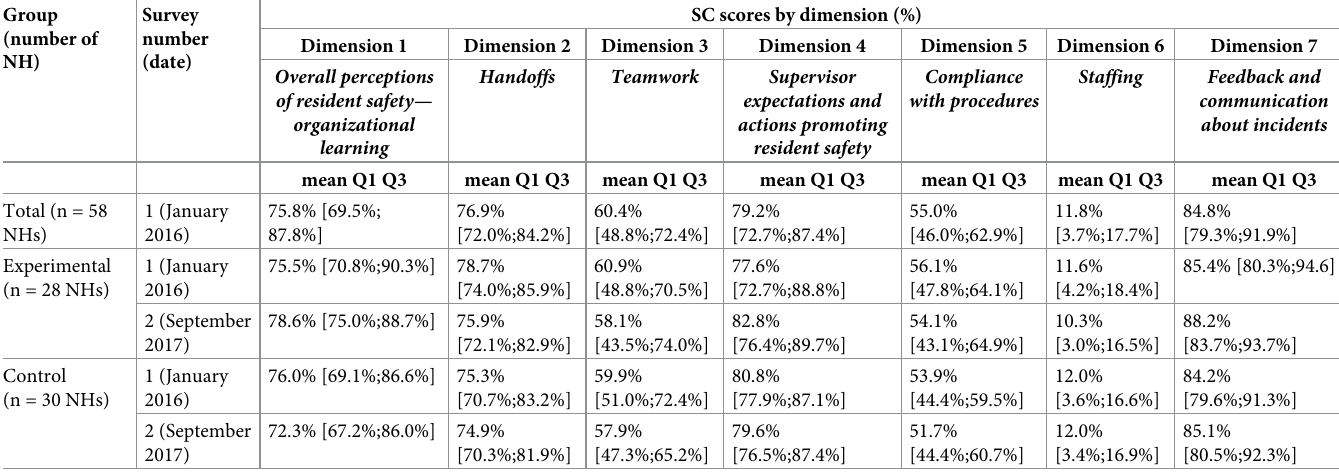
Table 3. Scores for each of the seven SC dimensions by group and survey round. Group (number of